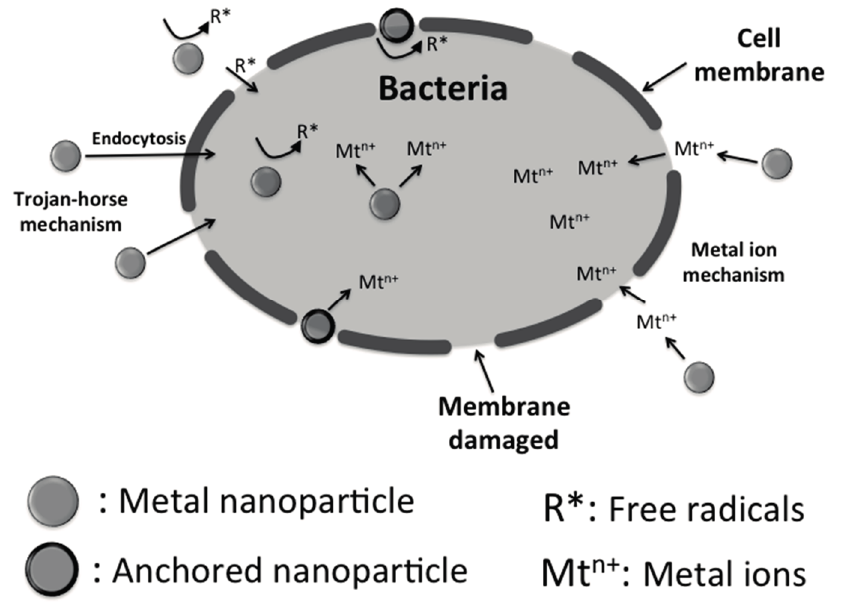
Figure 2. A summary of the mechanisms associated with the antimicrobial behaviour of metal nanoparticles: (1) “Trojan-horse effect” due to endocytosis processes; (2) attachment to the membrane surface; (3) catalyzed radical formation; and (4) release of metal